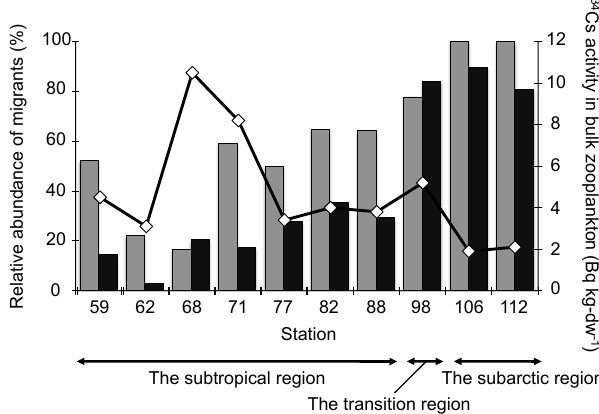
Fig. 6. Relative abundance (%) of diel vertical migratory species of euphausiids (gray bar) and copepods (black bar) in the euphausiid and copepod communities, respectively, in each station. A line graph shows spatial change of 134 Cs activity concentrations decay corrected to the sampling date in bulk zooplankton communities at the 10 stations in western North Pacific 10 months after the FNPP1 accident. Fig. 7. Relationships between relative biomass of each taxon and